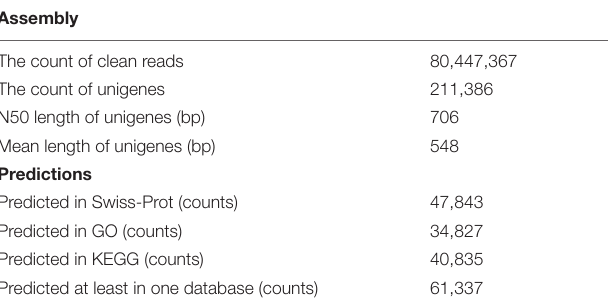
TABLE 1 | Summary of transcriptome assembly from S. Caldwelli